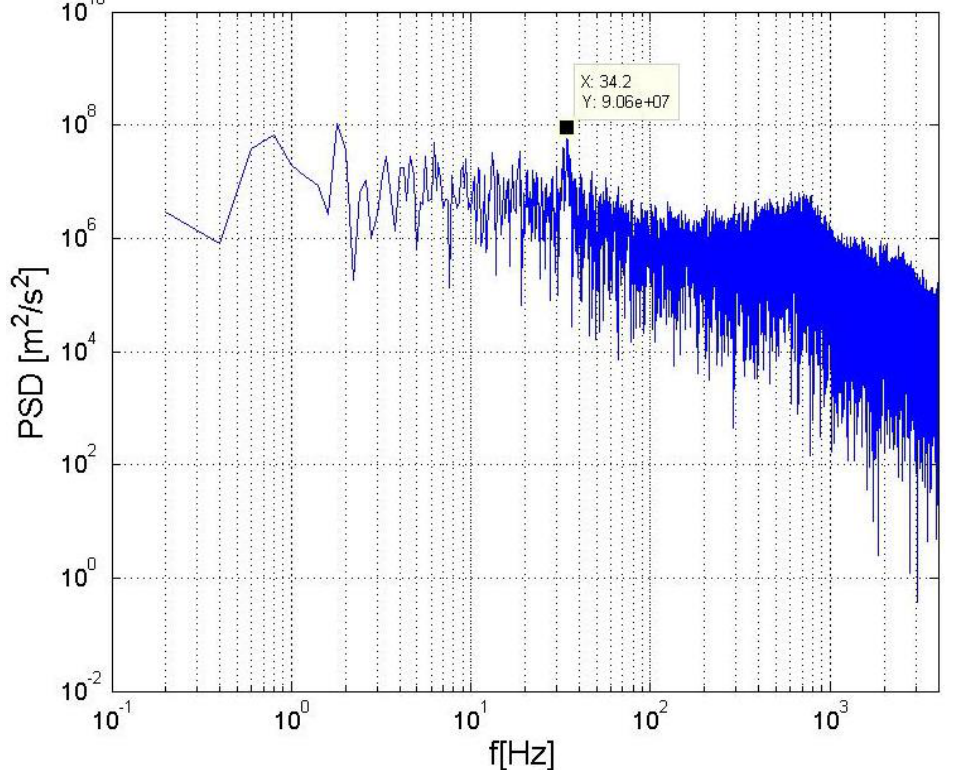
Figure 7. Power spectra along L1, Re = 100,000 and α = 24 ◦